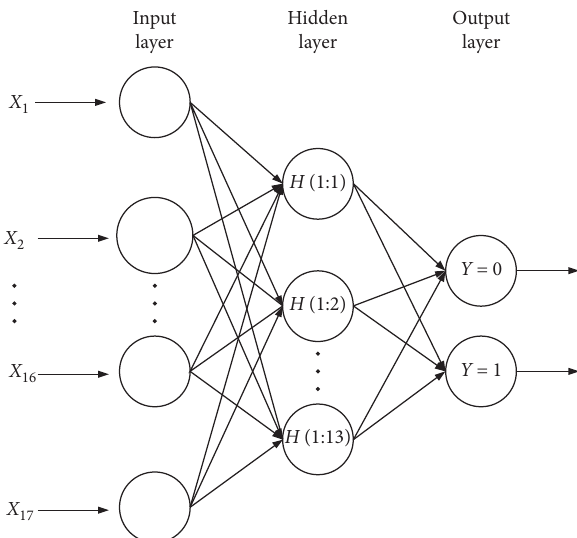
Figure 1: Schematic diagram of multilayer perceptual neural network